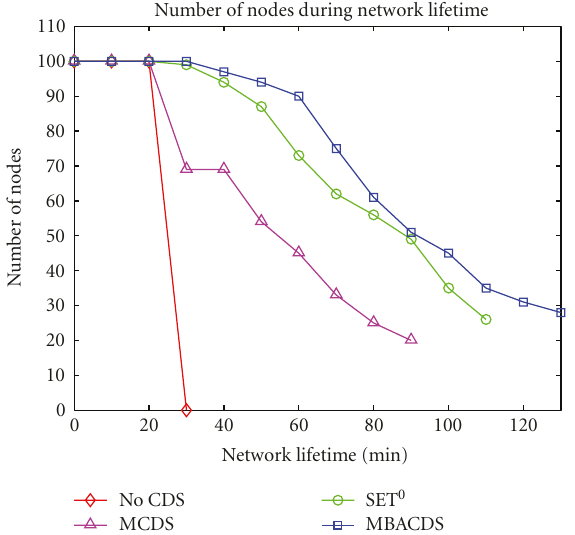
Figure 10: Mobility issue of BACDS. (a) A dominator moves away. (b) A new dominator is selected. Figure 11: Comparing the network lifetime under di